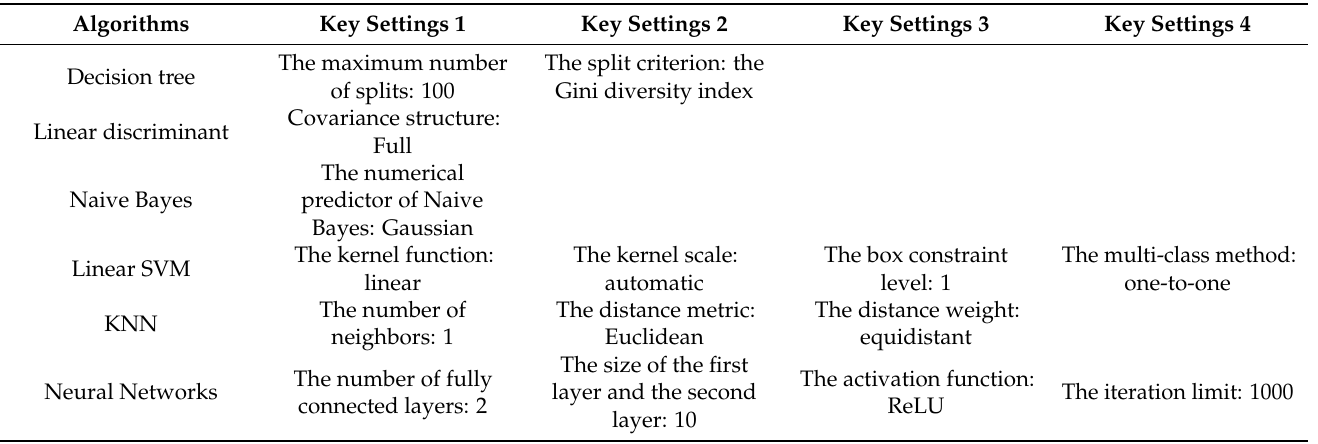
Table 2. Algorithms and key